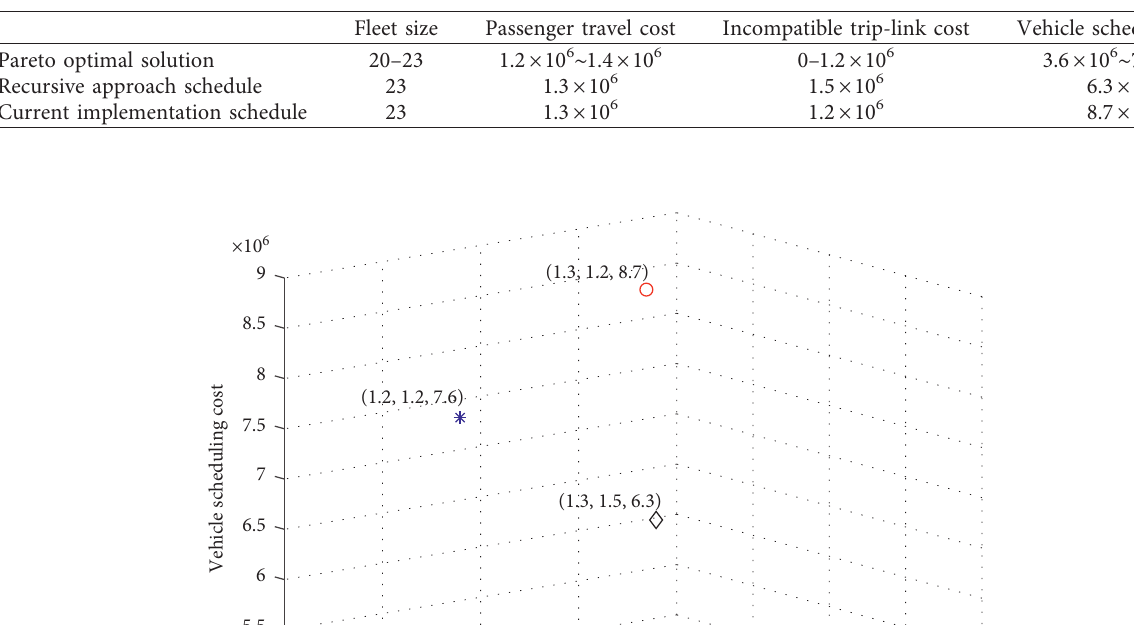
Table 7: Results of the different schedules.